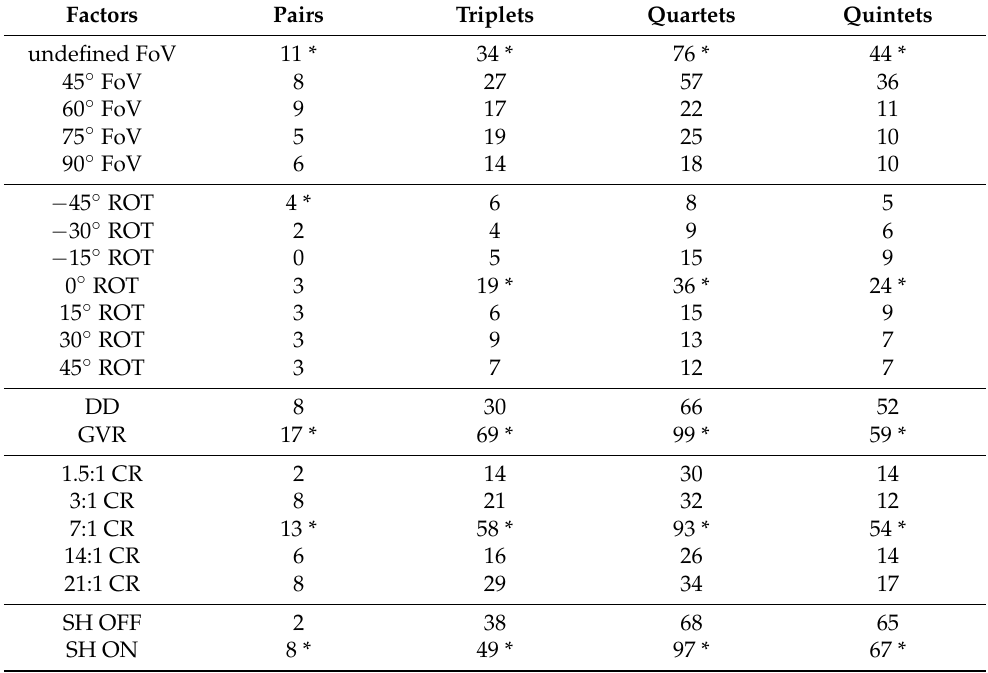
Table 6. Number of occurrences of each factor in significant combinations. The largest occurrence per factor is denoted by